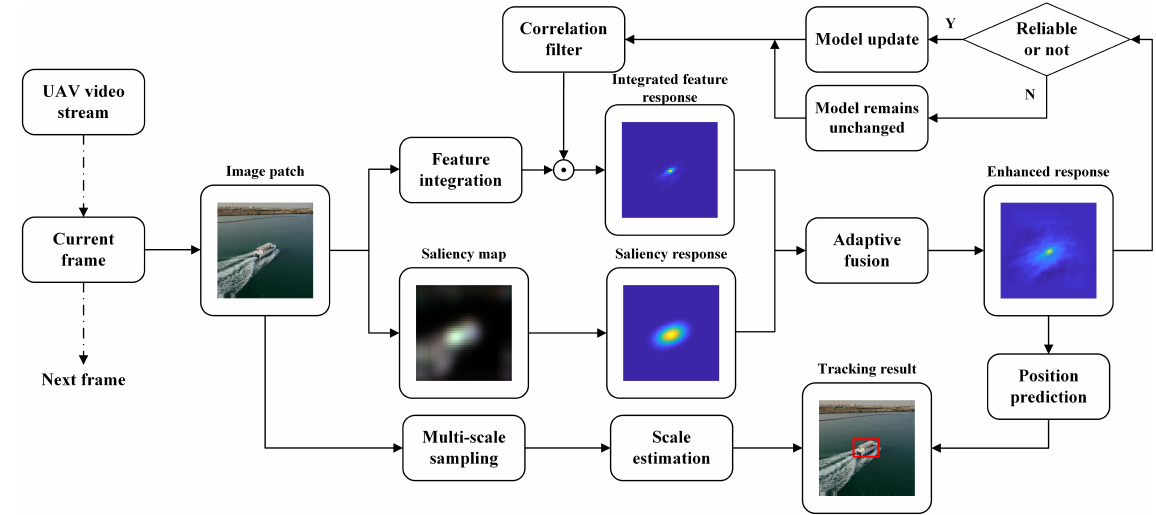
Figure 1. Overall workflow of the proposed